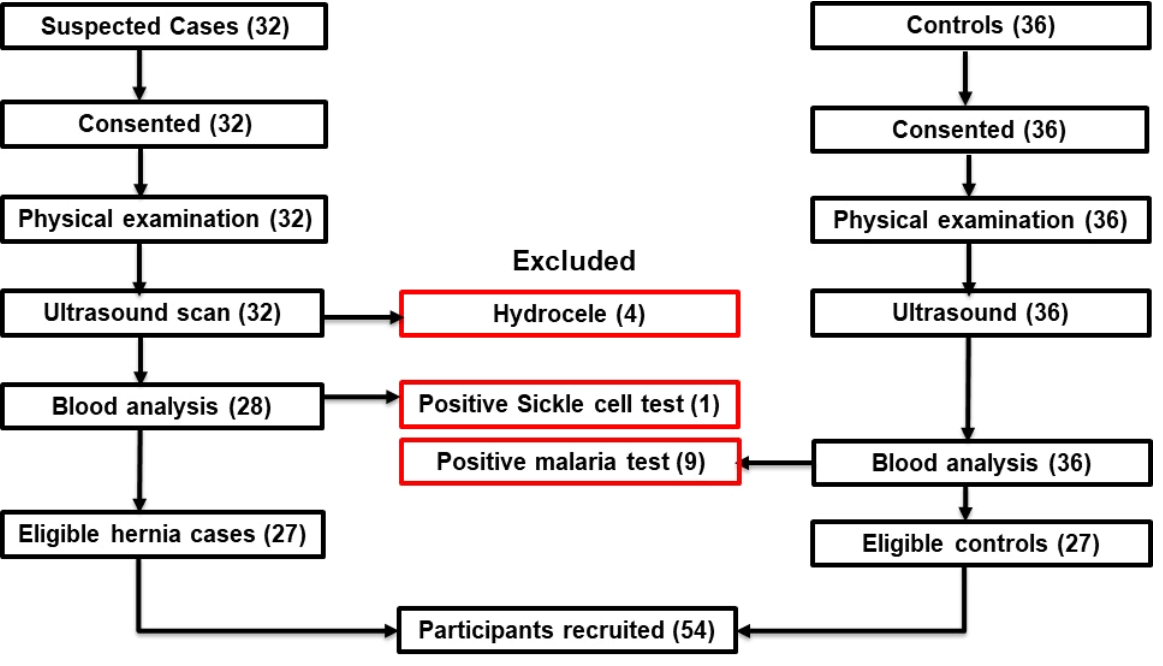
Figure 1. Flow chart of participant recruitment and exclusion at the Mankranso District Hospital,